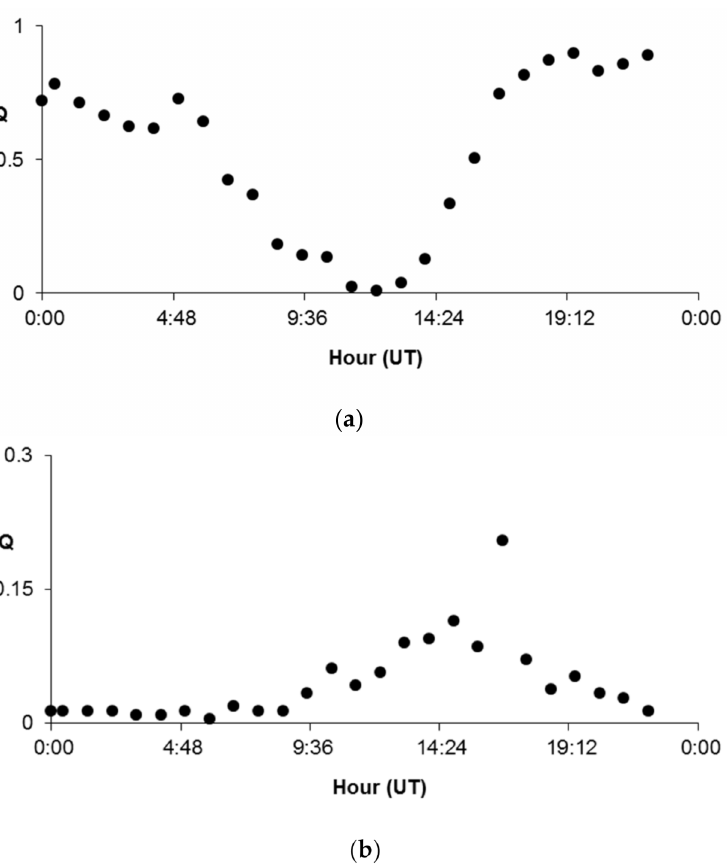
Figure 6. Diurnal variation profiles for broadcast allocations ( a ) 22 (5.950–6.200 MHz) and ( b ) 72 (21.450–21.870